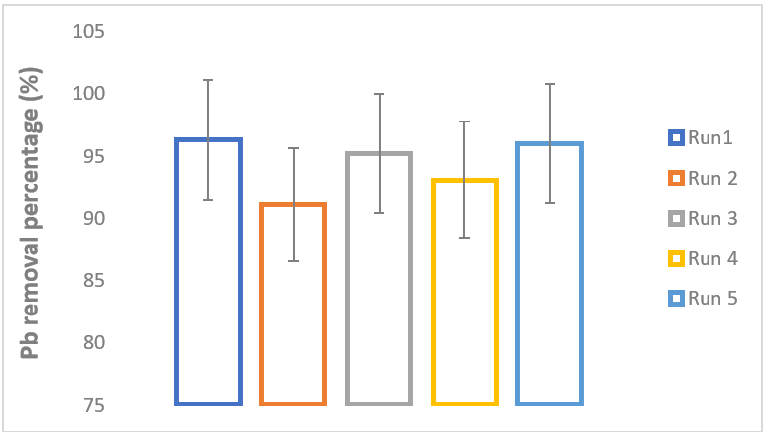
Figure 7. A set of experiments under optimal conditions (electrolysis time of 77.65 min and current intensity of 0.9 A) for Pb removal from DO concentrate of the actual metallurgical wastewater.